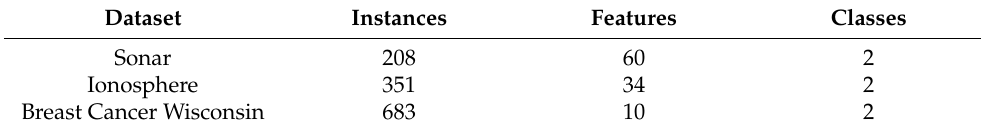
Table 5. UCI Benchmark Datasets.